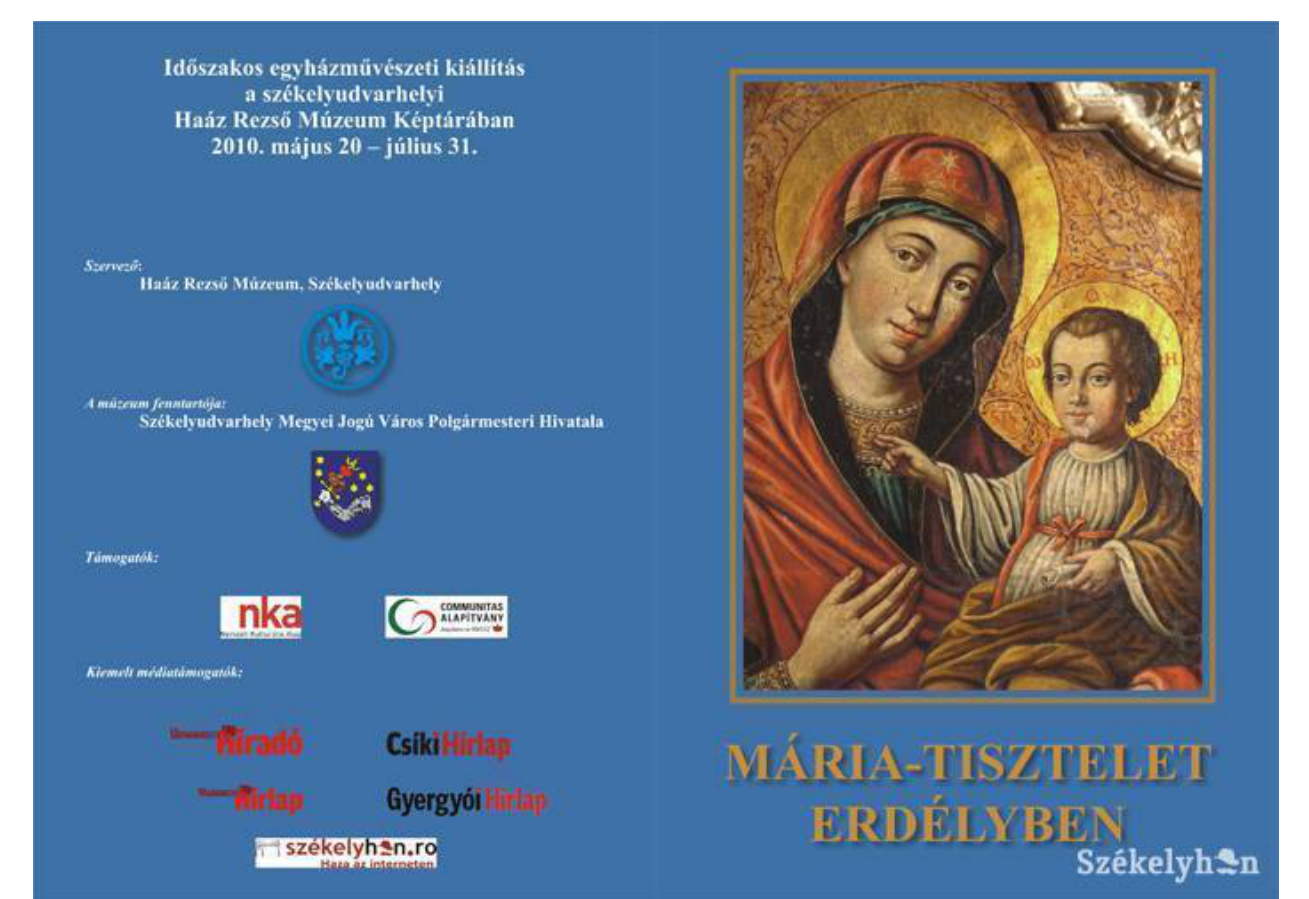
Figure 2. Invitation to Marian Devotionalism in Transylvania Exhibition Opening. The curators, ethnologists, and art historians who mounted this traveling exhibit also portrayed the Rezső Haáz Museum leading a rebirth of interest in devotional art after a long socialist-era dormancy. The Rezső Haáz Museum, the organizers claimed, was at the forefront of a movement to synthesize Catholic devotional practice with Hungarian na- tional identity. In the publicity for the exhibit, they argued that this synthesis was neces- sary to correct the ideologically-motivated mistakes of Romania’s post-World War II so- cialist regime. The socialist government drove the museum’s founder, Rezső Haáz, from public leadership amid the class warfare of the early socialist period. 3 Haáz was ostracized for his bourgeois class background and his collection of folk art sent to storage (Haáz Rezsõ Múzeum 2016). The museum’s official history describes the socialist period as a time of enforced dormancy: “With hindsight after the passing of decades, we can certainly say